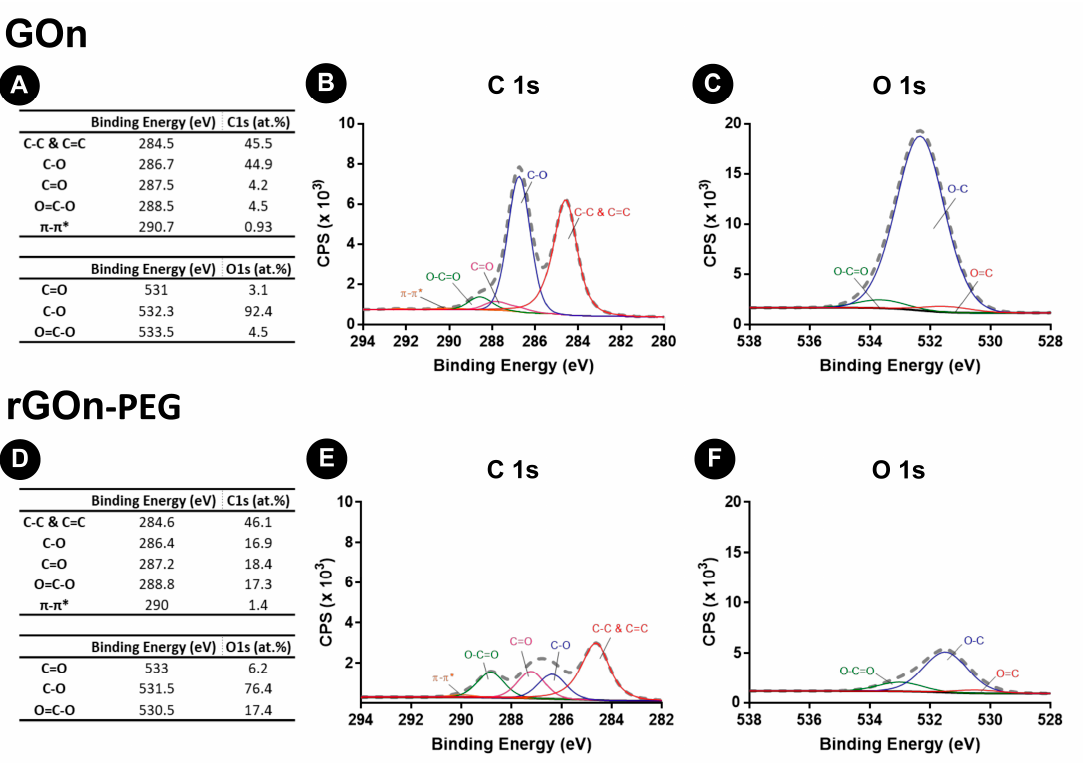
Figure 5. XPS analysis of GOn and rGOn-PEG. ( A ) Atomic composition of GOn and content of C 1s and O 1s chemical functional groups resulting from spectra fitting; ( B , C ) Deconvolution of high-resolution (B) C 1s and (C) O 1s XPS spectra for GOn. ( D ) Atomic composition of rGOn-PEG and content of C 1s and O 1s chemical groups resulting from spectra fitting; ( E , F ) Deconvolution of high-resolution (E) C 1s and (F) O 1s XPS spectra for rGOn-PEG.